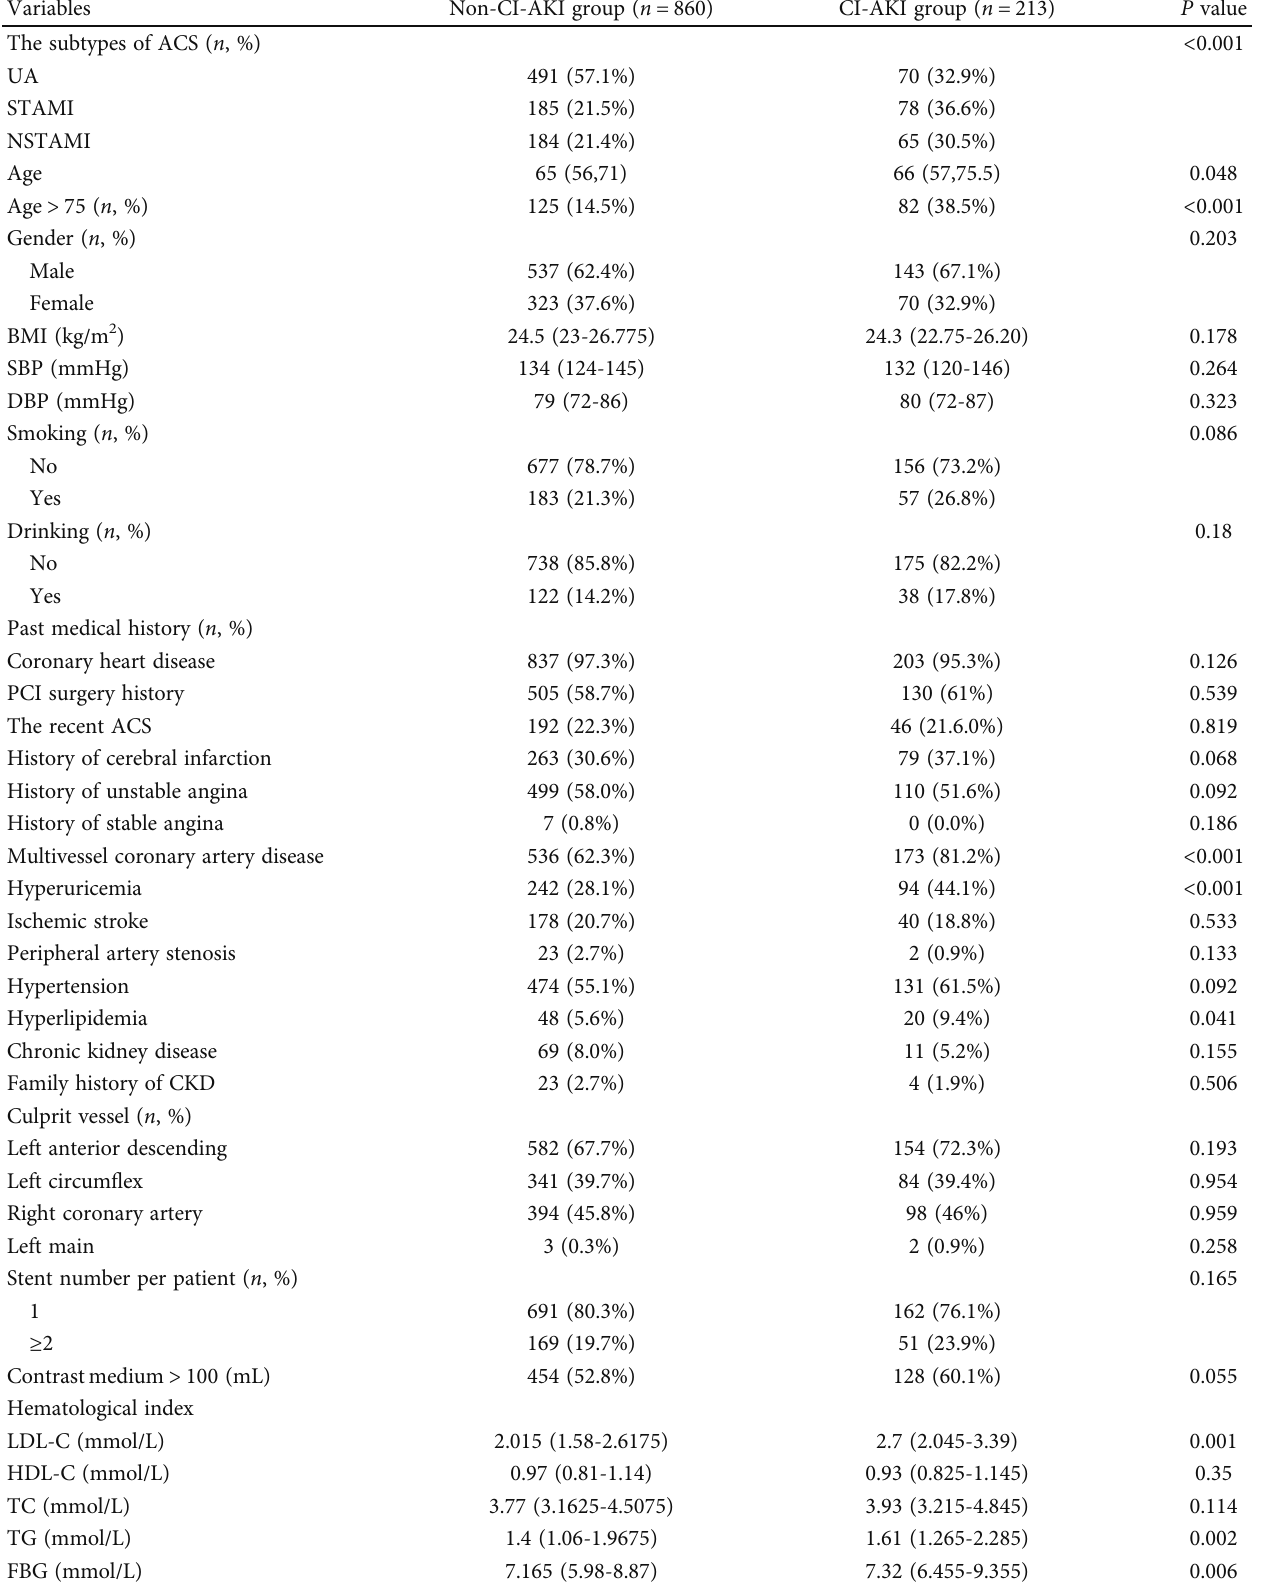
Table 1: Baseline characteristics of the non-CI-AKI group and CI-AKI